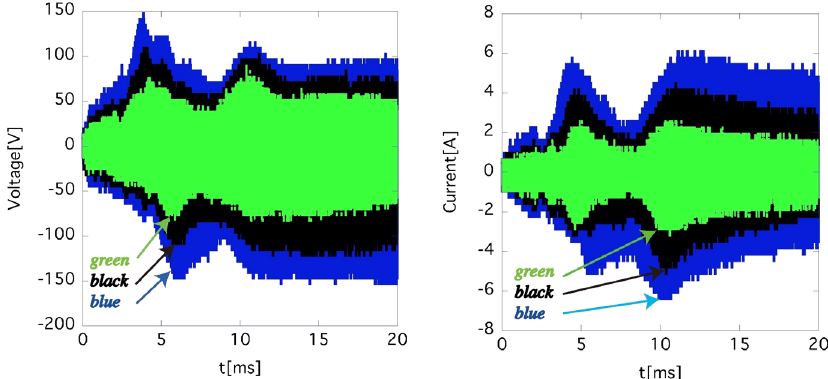
FIG. 14. Measurements of beam-induced voltages at the ends of coaxial cables (left) and the total currents of the two cables (right), when a beam passes through the kicker whose input cables are terminated with both diodes and resistors. The green, black and blue lines show the results for 1 . 245 × 10 13 (300 kW-eq), 2 . 075 × 10 13 (500 kW-eq), and 3 . 11 × 10 13 (750 kW-eq) particles per bunch,